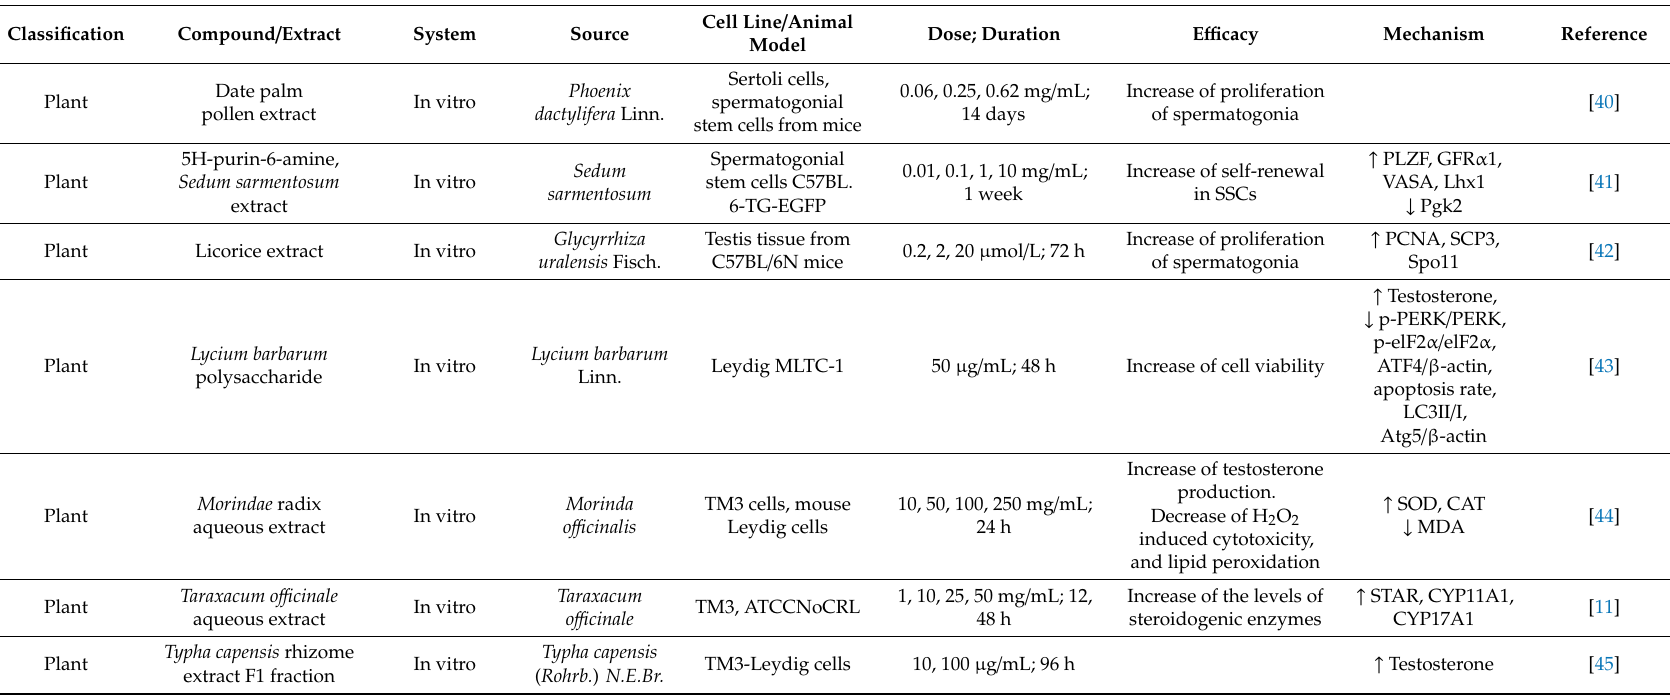
Table 1. Plant derived natural products and male infertility (in vitro